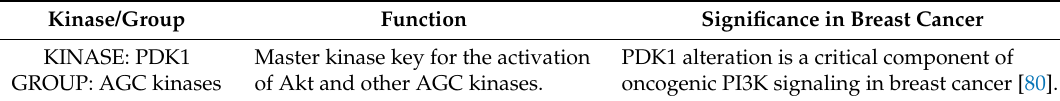
Table 6. PDK1 alterations and significance in breast